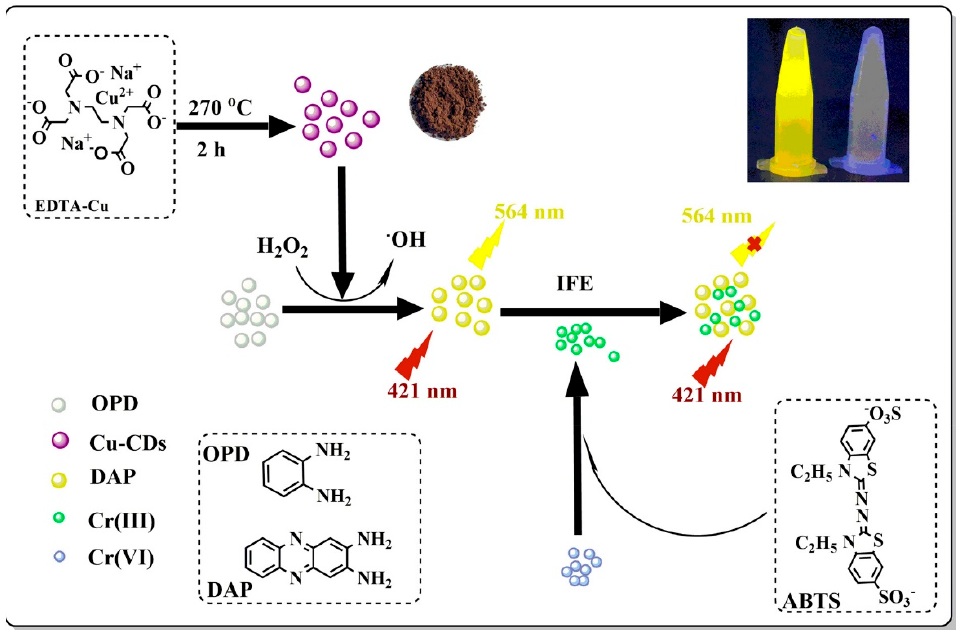
Figure 15. Spectrofluorimetric detection of Cr(III) and Cr(VI) based on the peroxidase-mimicking activity of Cu-CDs (reprinted with permission from [185], 2022, Elsevier).